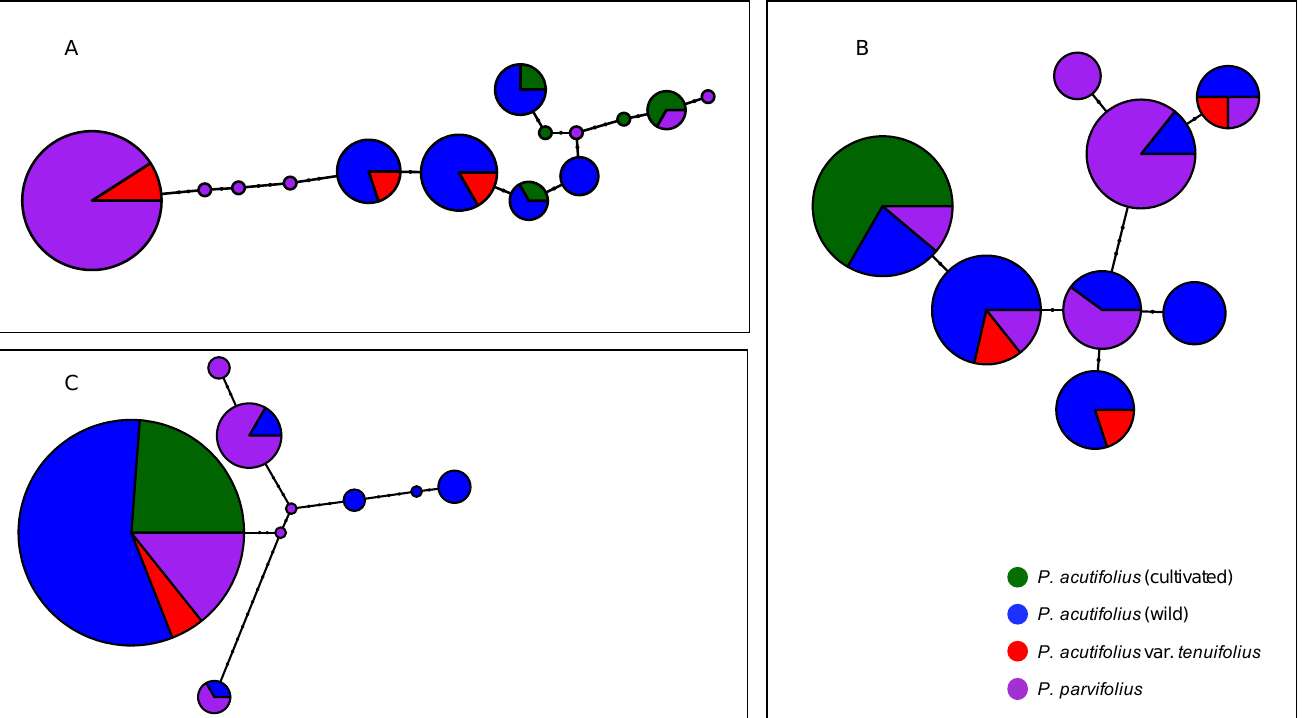
Figure 5. Haplotype networks of genetic polymorphism at ( A ) Asr2 , ( B ) Dreb2B , and ( C ) ERECTA -encoding candidate genes for drought tolerance in tepary bean s.l. ( P. acutifolius – parvifolius clade). Nodes represent haplotypes, its size relative to its frequency. Marks above each segment are substitutions. Nodes are colored by taxonomy (Table S1): Green and blue for cultivated and wild P. acutifolius , red for P. acutifolius var. tenuifolius , and purple for P. parvifolius , the latter two wild accessions.